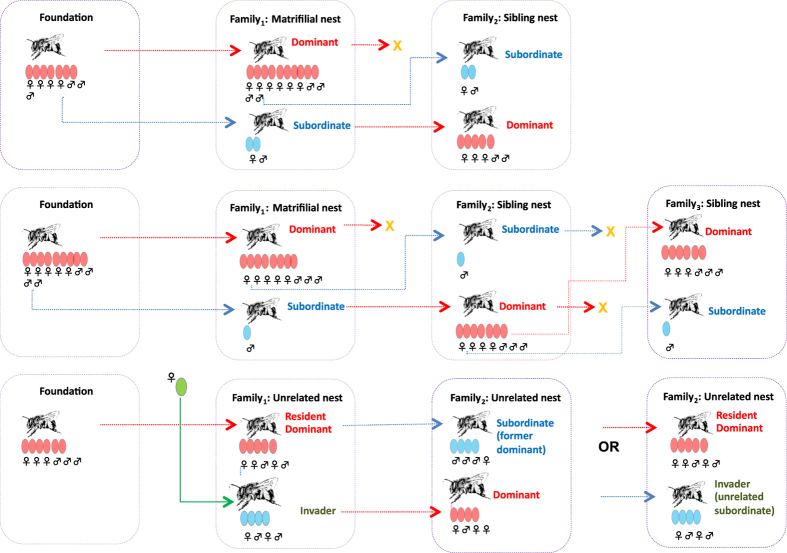
Life cycle and types of nest associations of Euglossa melanotricha.The cycle begins with a solitary nest founded by a single female. Two possible options of the first cohort females (blue label) are shown. Newly emerged females stay in the nest and become subordinates. They can inherit the nest when dominant dies or disappears or reactivate a nest with sisters. Subordinates will perform typical worker activities such as foraging and nest maintenance. However, subordinates share partially reproduction with dominants. Unrelated invaders can overthrow dominance when they are larger than residents or become subordinate helpers. Red arrows represent the routes of dominants and blue arrows represent the routes of subordinates. Letter X represents females dying or disappearing from the nest.